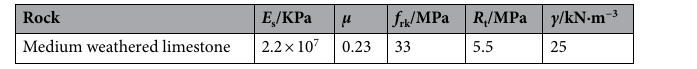
Table 4. Parameters of rock.